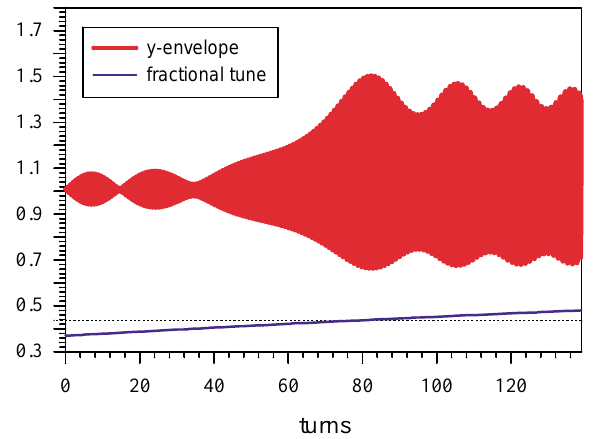
FIG. 17. (Color) Normalized y envelope (red) during crossing of resonance stop band in the direction of decreasing space charge [fractional depressed tune n y (blue) increases linearly in time from 4.37 to 4.48].